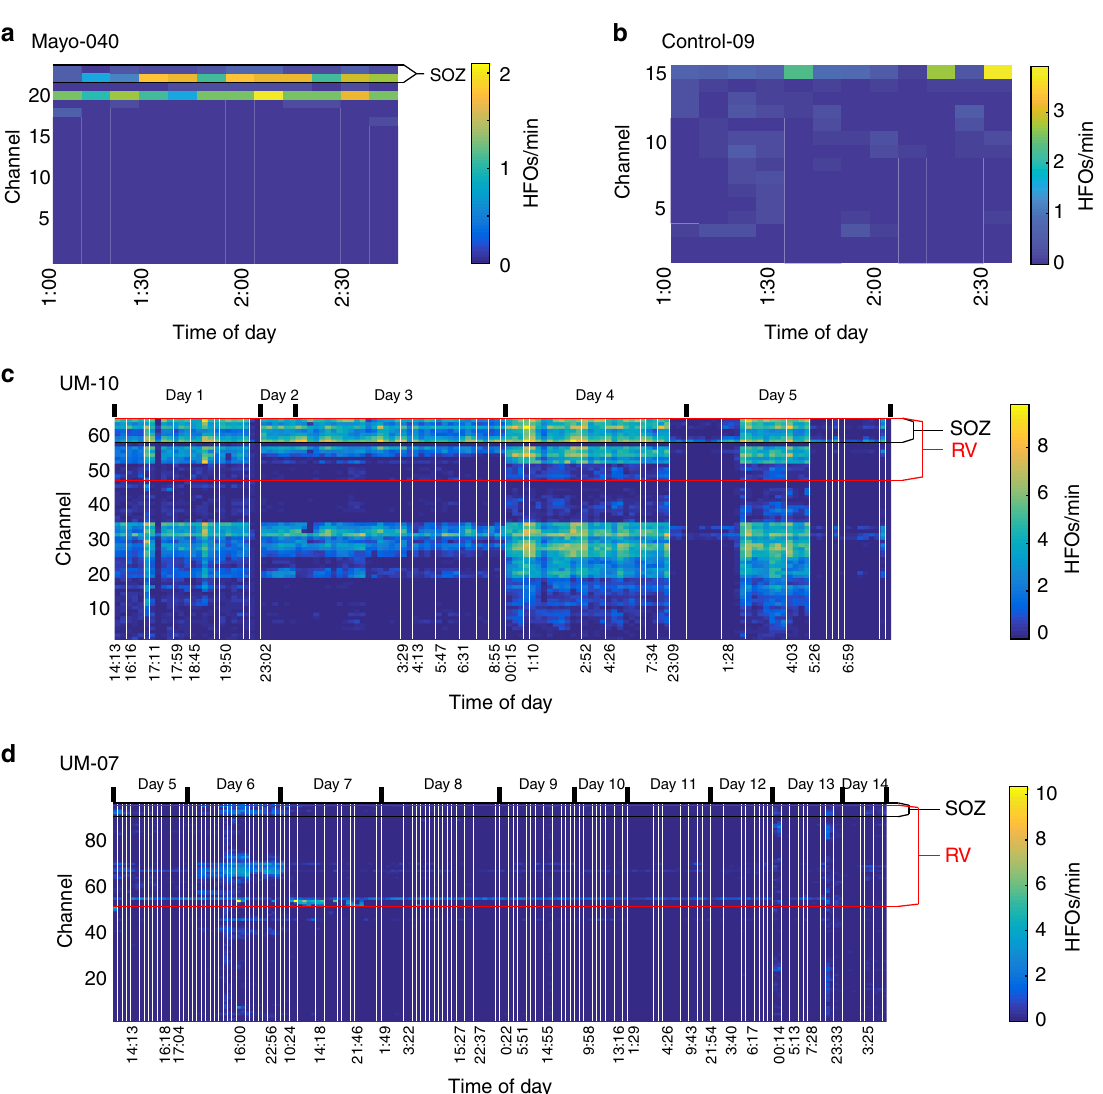
Fig. 1 Example rates of HFOs. The HFO rate per epoch of NREM sleep is shown for four example patients. All NREM data are concatenated together, with white vertical lines indicating breaks between NREM periods. a A small group of channels have high HFO rates, though the highest channel varies over time. b One channel is high but alternates with arbitrary groups with much lower rate. c Many channels are high in an organized cluster and all appear well correlated. d Much more complex patterns are also observed, in which different channel groups dominate on different days. Channels in the resected volume (RV) and clinically determined seizure onset zone (SOZ) are ordered together, as are channels with similar temporal dynamics in HFO rates. Note that patients in a and b did not have a